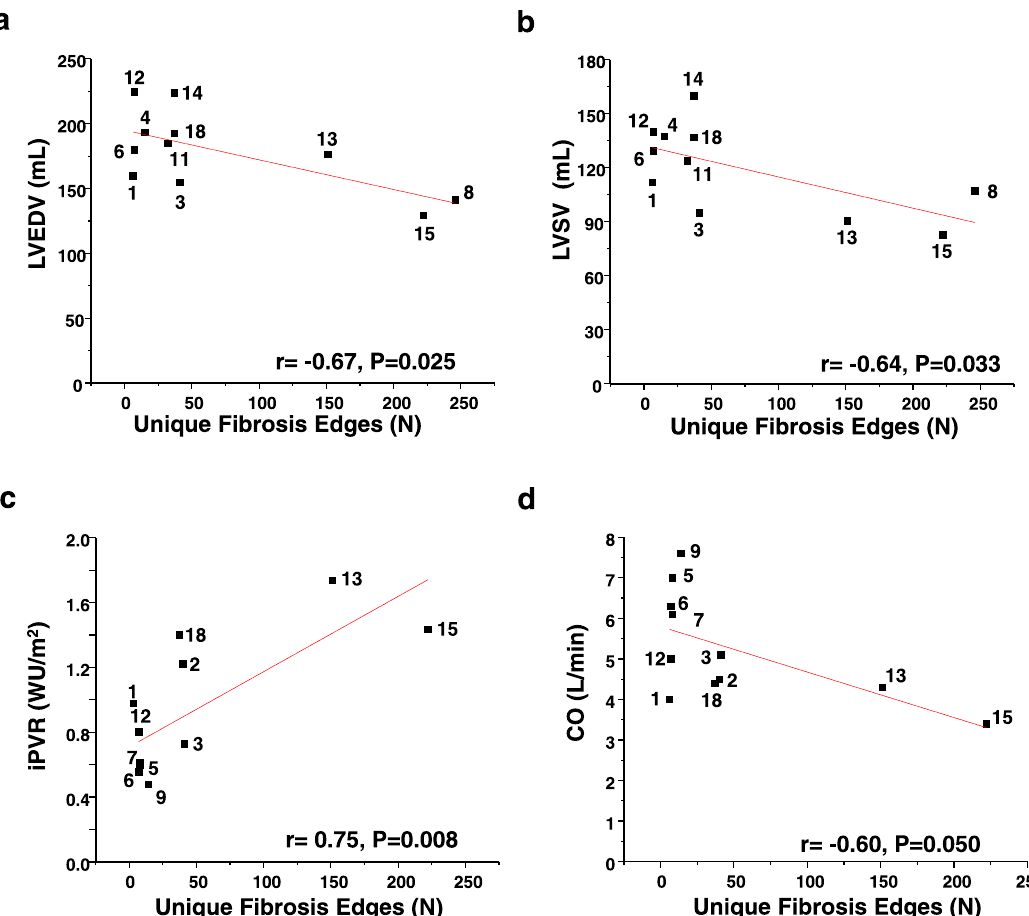
Fig. 4 Number of unique fi brosis edges informs predictive physiological parameters in HCM heart failure clinically. The number of unique fi brosis edges, de fi ned as the number (N) of edges unique to a single HCM patient network that also involve at least one fi brosis gene, was calculated. a – c The number of unique fi brosis edges correlated inversely with decreasing left ventricular end-diastolic volume (LVEDD) ( N = 11) and left ventricular stoke volume (LVSV) ( N = 11), and positively with indexed pulmonary vascular resistance (iPVR) ( N = 11), which are pathological, morphological, functional, and hemodynamic changes, respectively, that promote HCM heart failure. d Furthermore, the number of unique fi brosis edges correlated inversely with cardiac output ( N = 11), suggesting, overall, that heart failure severity in this HCM study cohort was associated with the number of unique fi brosis edges on an individual-patient level. CO, cardiac output; WU, Wood unit. a – d Pearson ’ s and correlation analysis was performed. For a – d , the HCM patient number is provided with each datapoint. Source data are